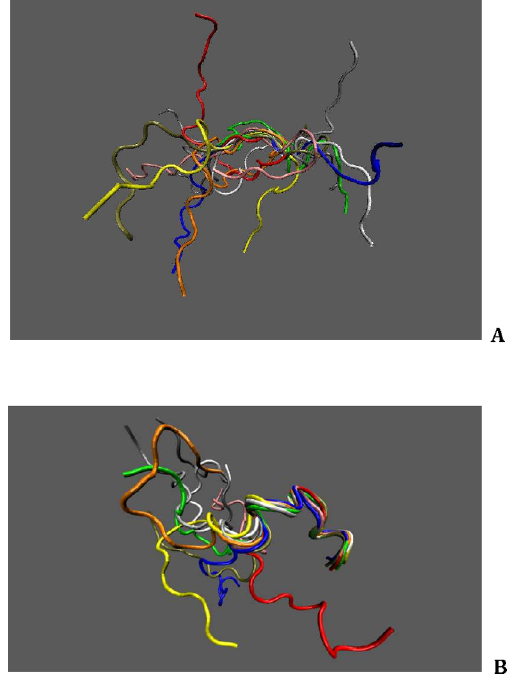
Figure 1. Lowest energy NMR solution structures of SOR-C27. A representative NMR solution structure of 10 mM SOR-C27 in 50 mM potassium phosphate buffer, 200 mM NaCl or 100 mM dodecylpho- sphocholine ( A ). A representative NMR solution structure of 2 mM SOR- C27 in anionic 100 mM sodium dodecylsulfate micelles showing induction of helical structure from residues 15 to 25 ( B ).